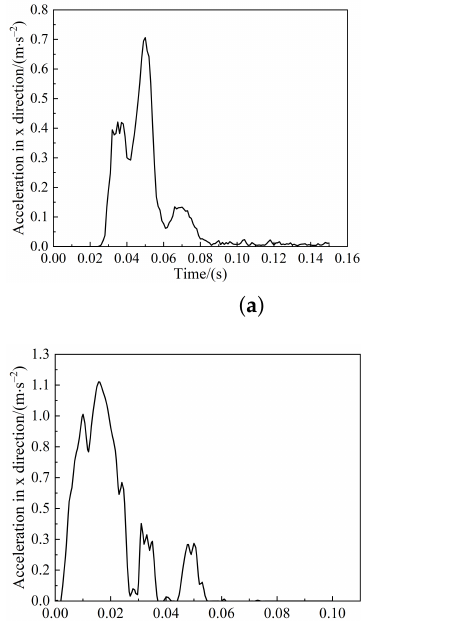
Figure 22. Collision energy curve: ( a ) Total energy and kinetic energy curve of frontal collision of cow; ( b ) internal energy and hourglass energy curve of frontal collision of cow; ( c ) total energy and kinetic energy curve for cow bias collisions; ( d ) internal energy and hourglass energy curve for cow bias collisions.